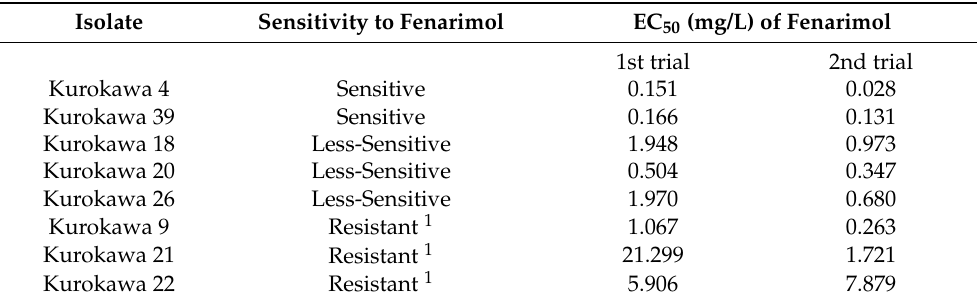
Table 6. Change of fenarimol sensitivity in single-spore isolates of Venturia nashicola after storage at